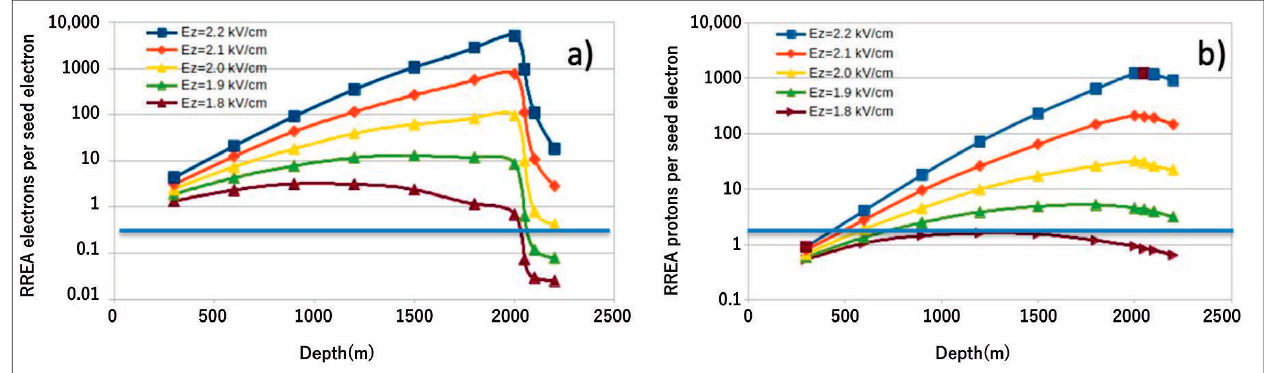
Figure 6. Development of the RREA in the atmosphere ( a ) electrons ( b ) gamma rays. The avalanche began at an altitude of 5400 m above sea level (depth 0), i.e., 2200 m above the Aragats station. The number of avalanche particles is calculated every 300 m. After leaving the electric field, the tracking of avalanche particles continues another 200 m until reaching the ground. The blue line shows the number of electrons and gamma rays per seed electron per m 2 measured on 14 June 2020 (see Table 1).